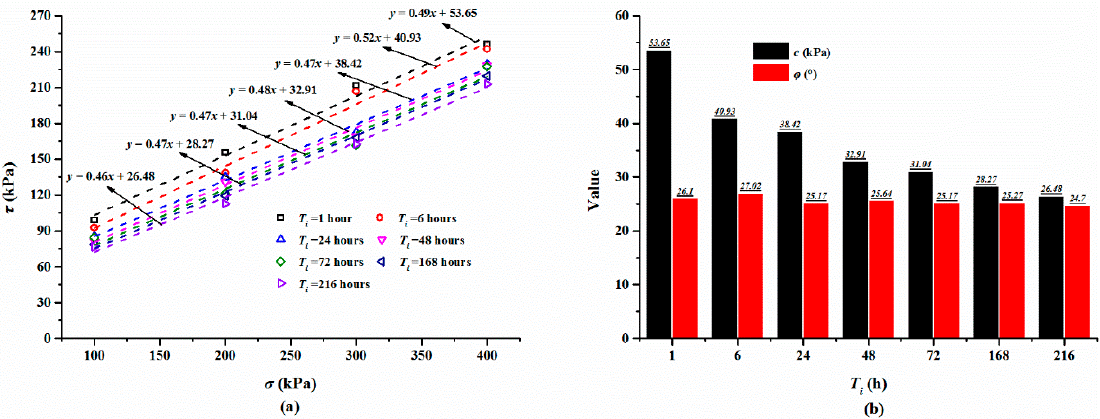
Figure 10. ( a ) The variation of the shear strength τ and normal stress σ ; ( b ) The variation of the shear strength parameters ( c and φ ) and immersion time T i .